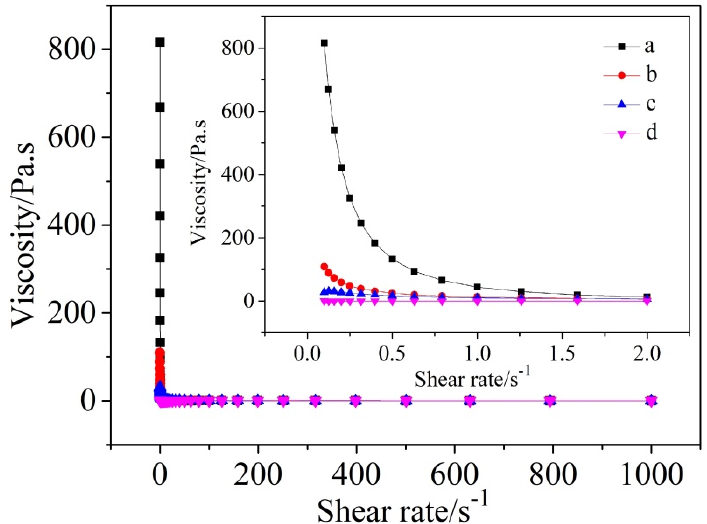
Figure 6. Viscosity–shear rate curves for cement-water slurries added with different amounts of SHMP: (a) without SHMP, (b) with 0.1% SHMP, (c) with 0.2% SHMP, and (d) with 0.4% SHMP.